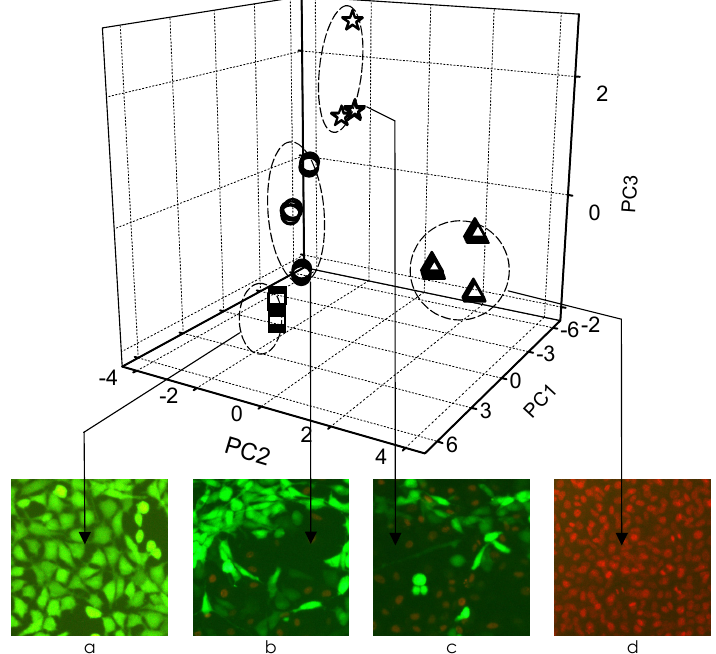
Figure 5. PCA plot of the toxic effects of 1,4-dioxane on Vero cells: ( a ) Vero cells cultured in a routine way, ( b, c, d ) Vero cells treated with different concentrations of 1,4-dioxane. The application of PI (marker of dead cells) and FDB (marker of living cells) showed nearly 100% (a), 70% (b), 40% (c) and 0% (d) of living cells (With kind permission from Springer Science+Business Media: Analytical and Bioanalytical Chemistry)